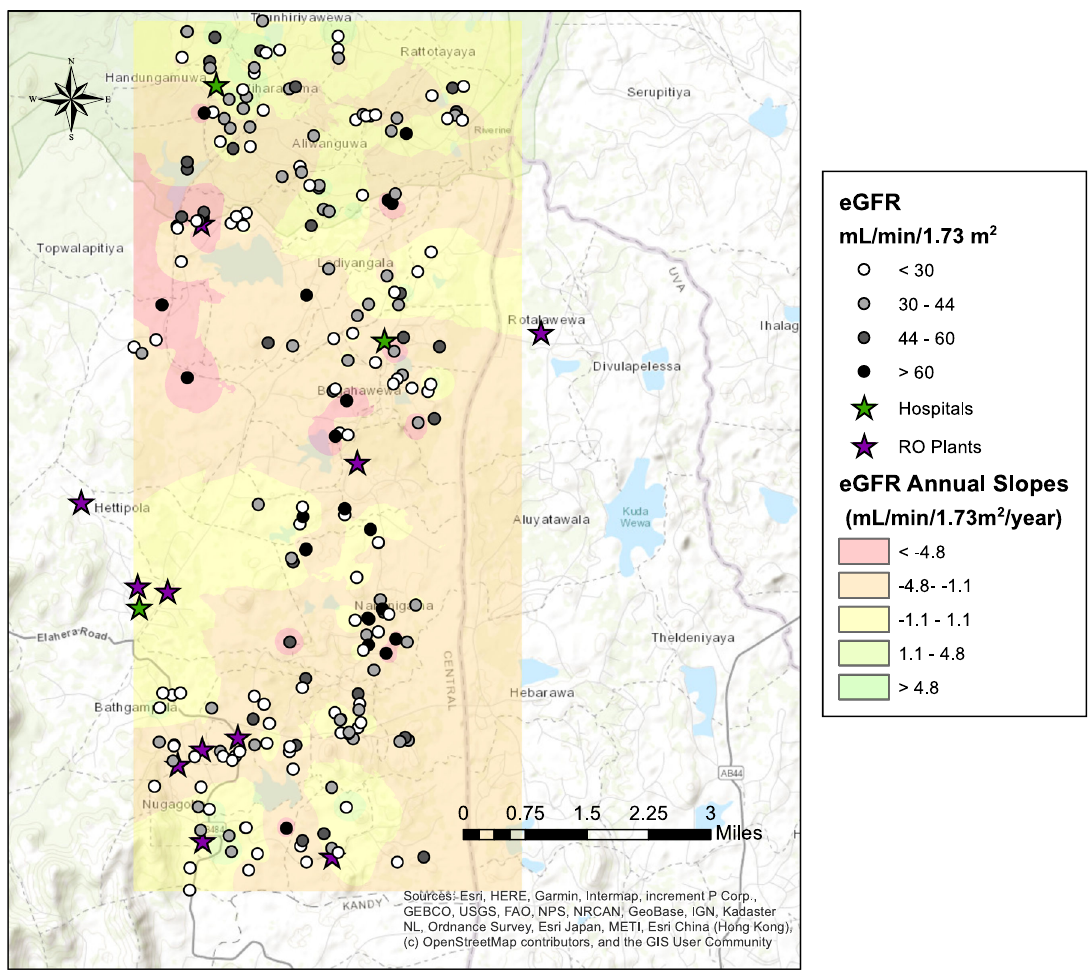
Fig. 2 Spatial analysis of participant baseline eGFR (shaded circles) and CKDu progression over the study period (base map contours). Also illustrated on the map are the locations of reverse osmosis (RO) plants which ration free drinking water to residents as of late 2017 and the location of the three regional